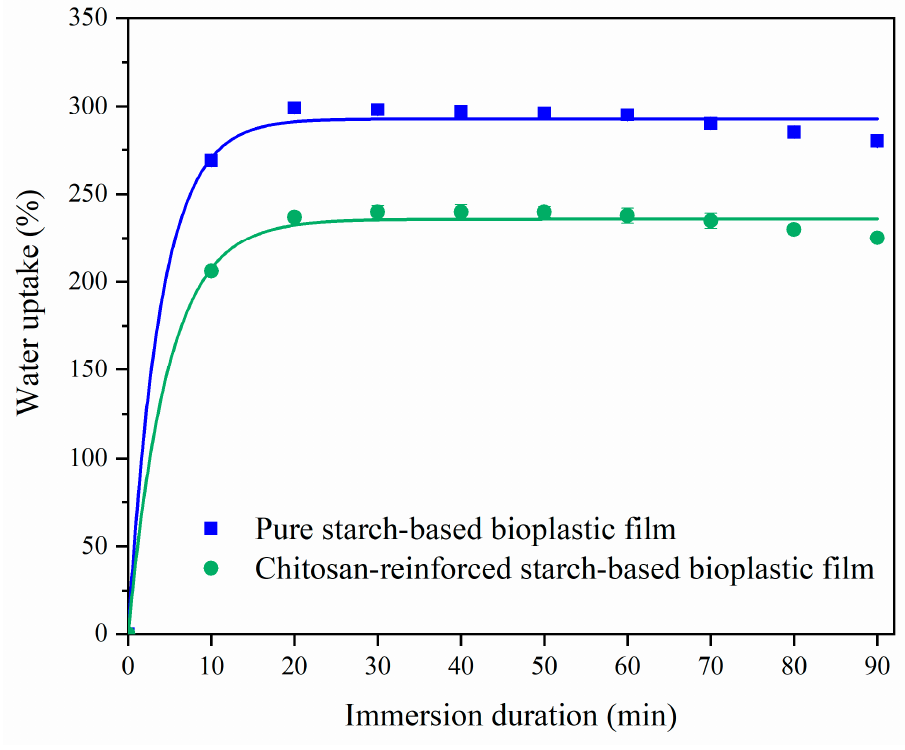
Figure 13. Water uptake percentages of pure starch-based and chitosan-reinforced starch-based bi- oplastic film at various immersion durations.